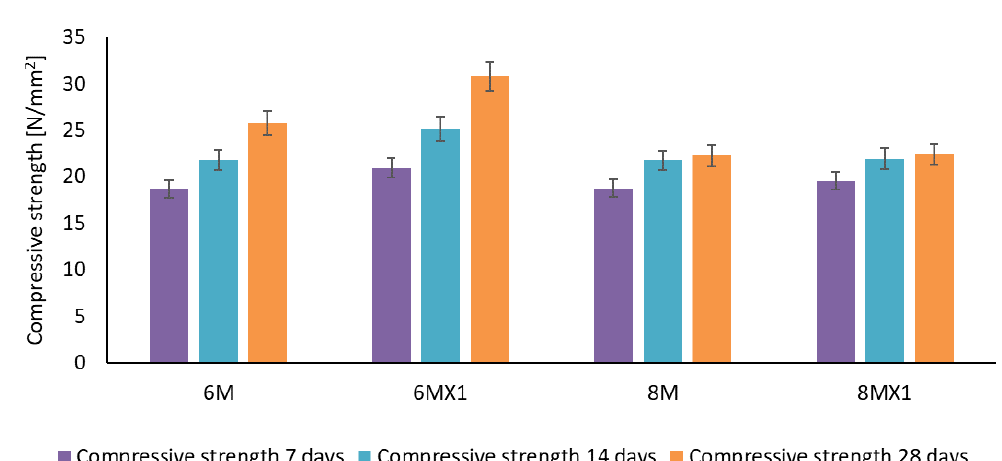
Figure 3. Compressive strength of the alkali-activated geopolymer samples.